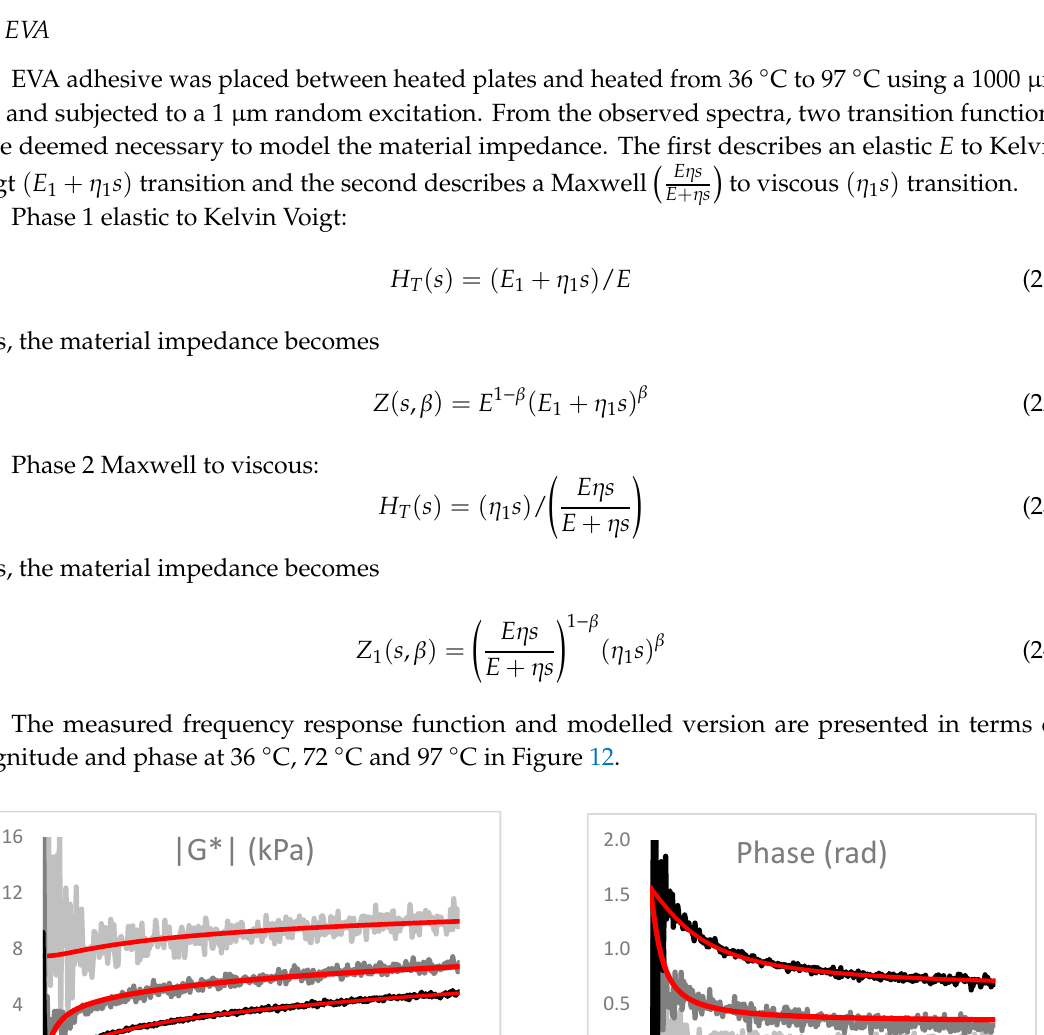
Figure 13. Experimental frequency response for EVA near the melting point, at 79 ° C - 64 ° C . Parameter values for phase 1 (solid) and phase 2 (liquid) are presented in Tables 3 and 4, respectively.